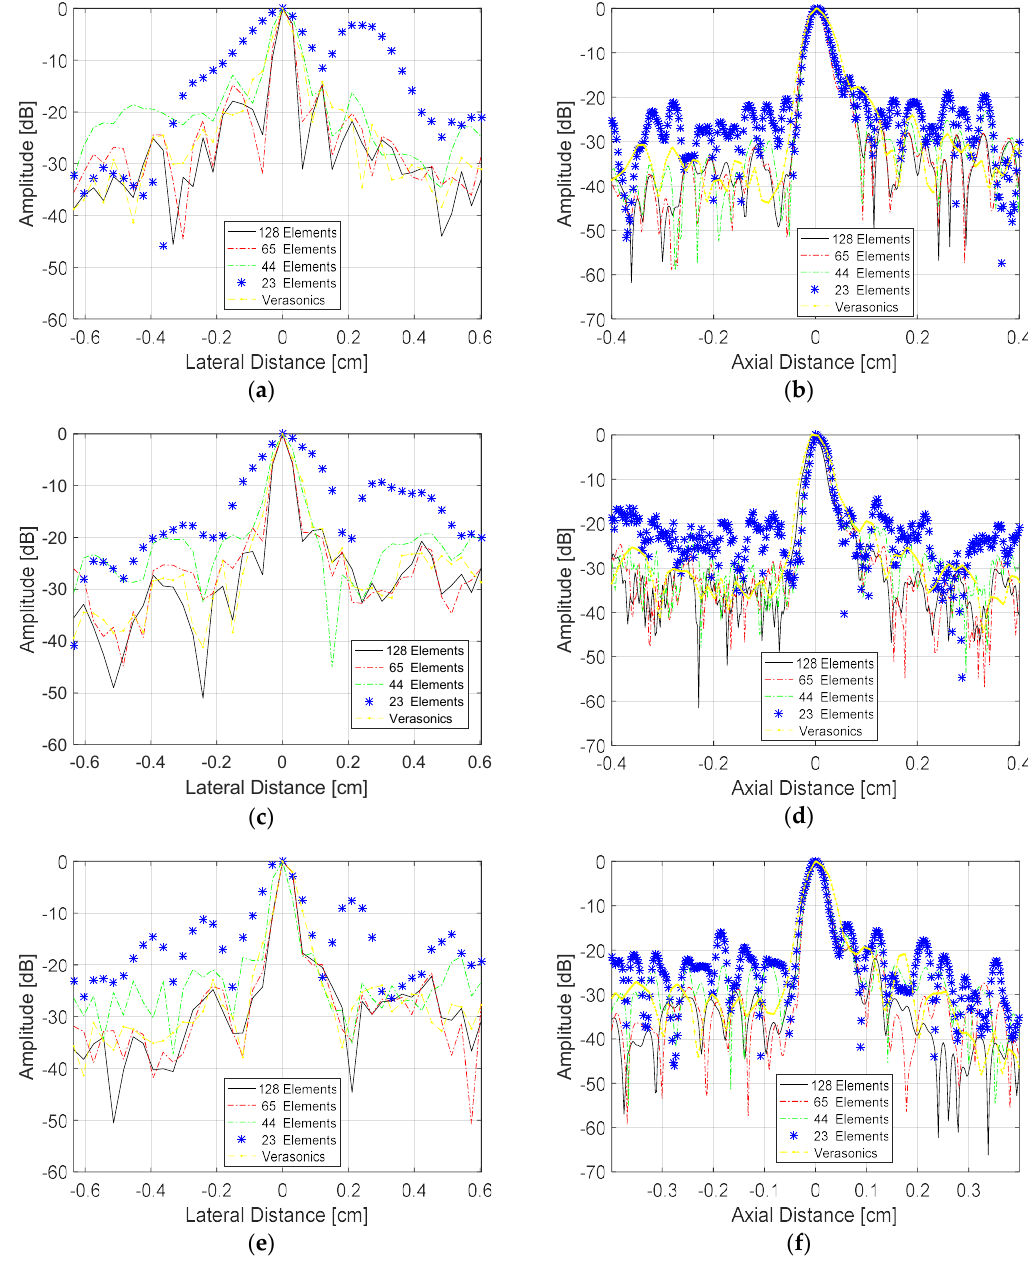
Figure 14. Analysis of the lateral resolutions ( left ) and axial resolutions ( right ) of the target at the depth of 1.7 cm (Figure 13) for angles ( a , b ) in the range −1.5 to +1.5° and 0.5° step; ( c , d ) −3.0 to +3.0°, 1.0° step; ( e , f ) −4.5 to + 4.5°, 1.5° step, respectively.